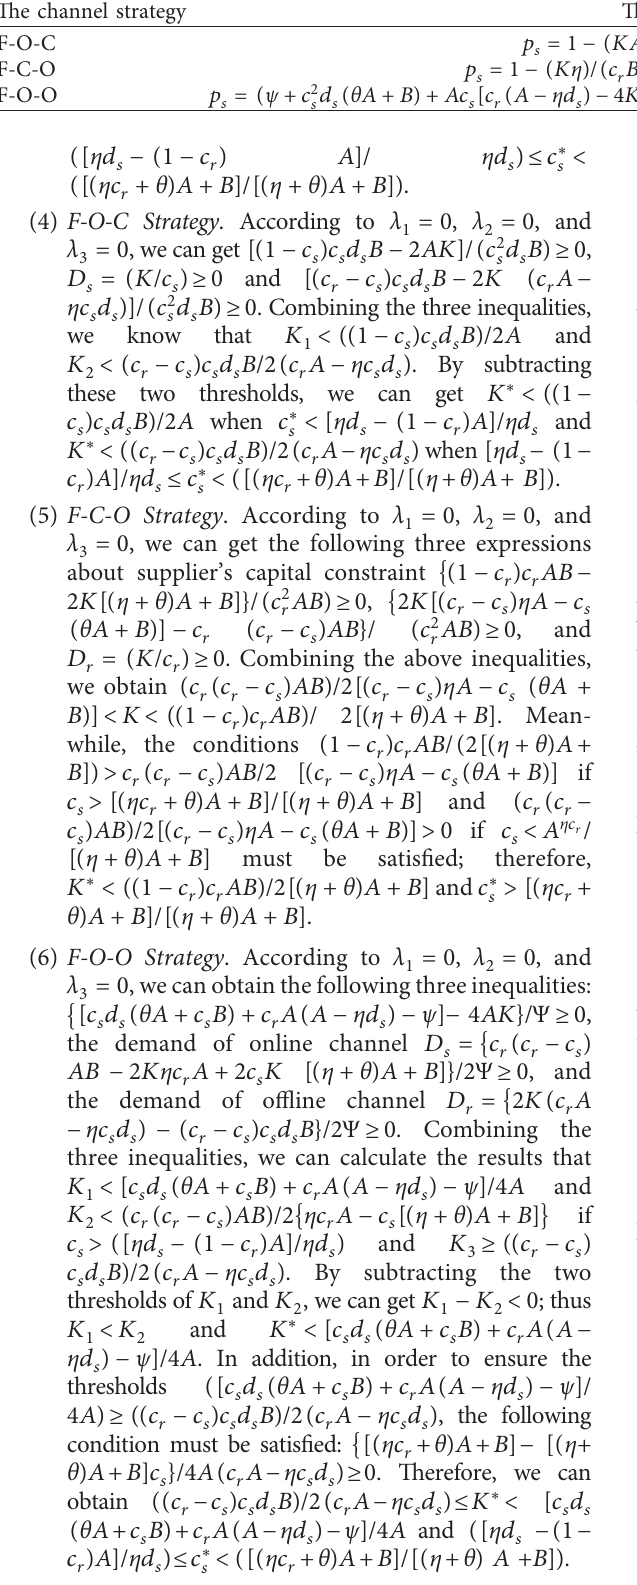
Table 3: The optimal channel strategy and pricing decisions when supplier’s capital is fully used. The channel strategy The pricing